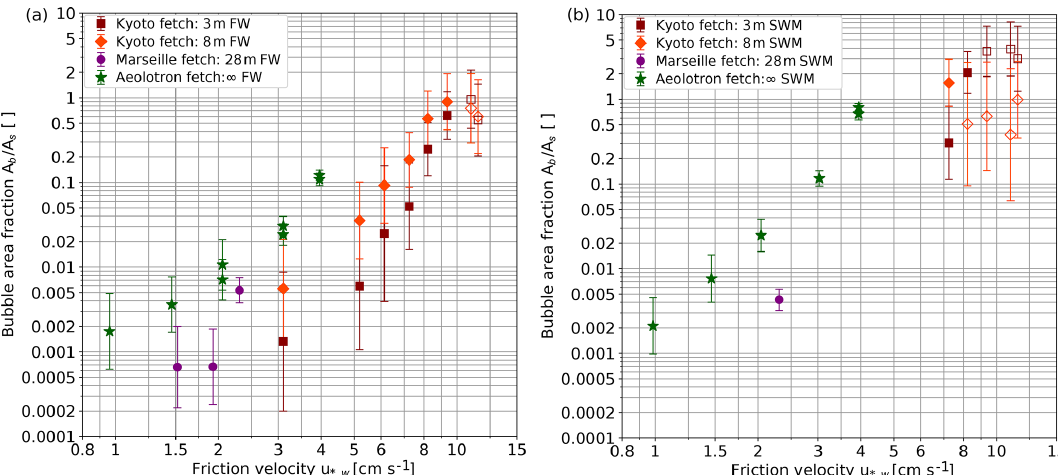
Figure 5. Bubble surface area per water surface area measured in fresh water (a) and seawater modeled by adding butanol to fresh wa- ter (b) Kyoto: 3 and 8m fetch, with the camera installed approximately 30cm below water surface at rest; Marseille Luminy: 28m fetch, with the camera installed at approximately 50cm below water surface at rest; Aeolotron Heidelberg: infinite fetch, with the camera installed at 10 evenly spaced positions between 0.5 and 36.5cm below the water surface. At the highest wind speeds, the density of the bubbles is so large that the intensity of the illumination that reaches the camera is reduced by up to 75%, which leads to a systematic underestimation of the bubble surface area. Conditions likely affected by this are marked with an open symbol. Figure reproduced from data by Flothow (2017).